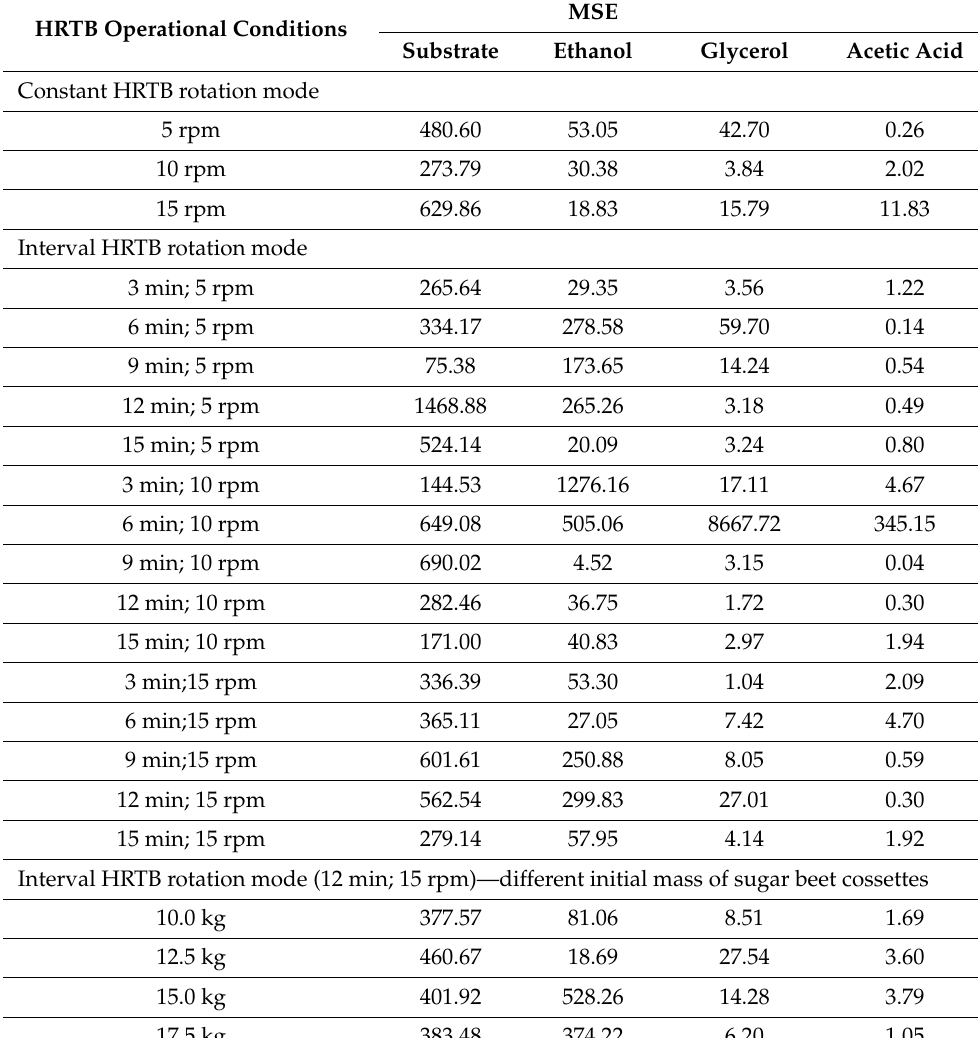
Table 4. Mean square errors for bioethanol production in the HRTB under different bioreactor operational